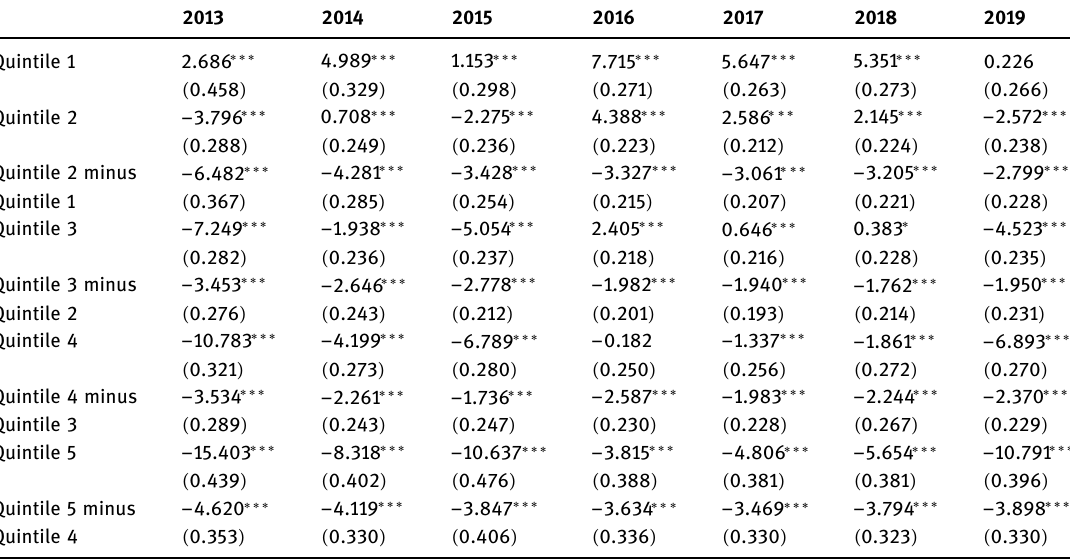
Table 6: Net total e ff ect by quintiles of TPS t −1 : Predicted TPS minus lagged